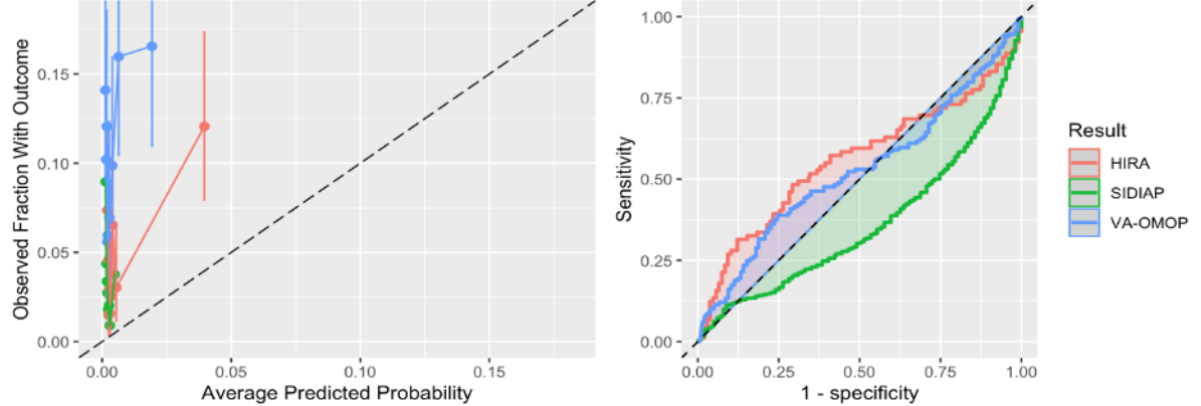
Figure 1. Receiver operating characteristic and calibration plots of the COVID-19 vulnerability index model for the three data sets with sufficient and suitable COVID-19 data. HIRA: Health Insurance Review and Assessment; SIDIAP: Information System for Research in Primary Care; VA-OMOP: Department of Veterans Affairs– Observational Medical Outcomes